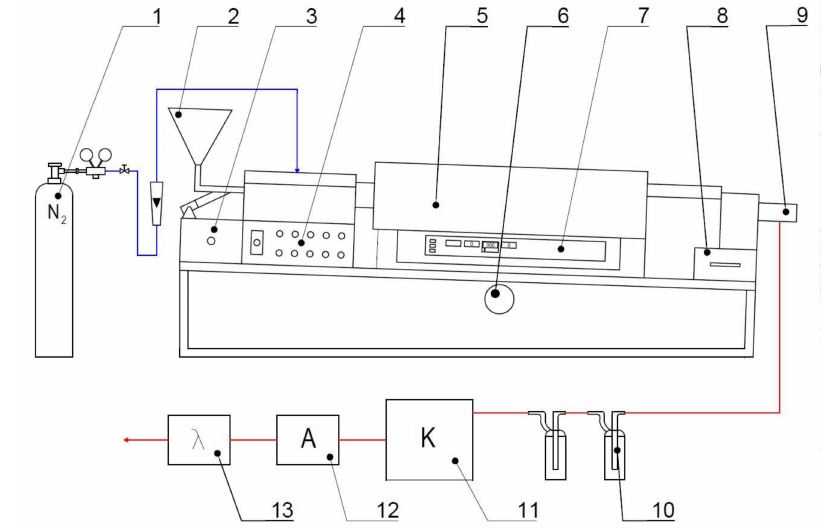
Figure 2. Diagram of the rotary isothermal torrefaction reactor (1—cylinder with nitrogen; 2—feedstock hopper; 3—electric motor; 4—control panel; 5—rotary drum; 6—regulation of the tilt; 7—temperature control panel; 8—container with torrefied product; 9—sampling of torgas; 10—impinger bottles; 11—conditioner; 12—FTIR gas analyzer; 13—Electrochemical O 2 analyzer).